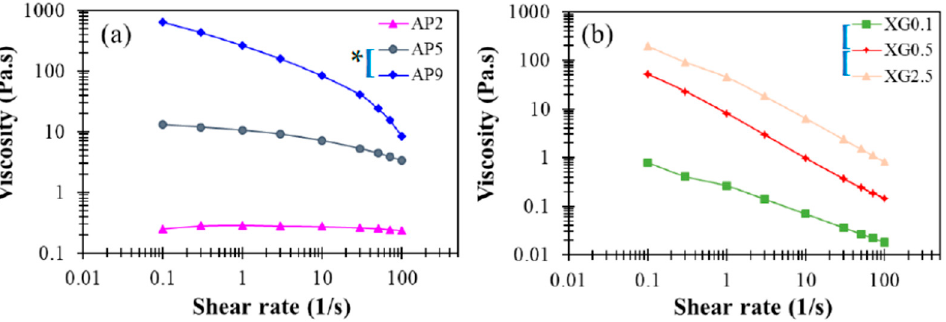
Figure 3. Steady-state viscosity profiles as a function of shear rate for ( a ) AP and ( b ) XG hydrocolloids at various concentrations with viscosity ranging from 0.01 to 1000 Pa.s. The indicated left brackets ([) marked on sample labels are significantly different from each other at the 5% level by a paired t -test; the indicated left brackets with an additional star (*[) marked on sample labels are significantly different from each other at the 1% level for a paired t -test.